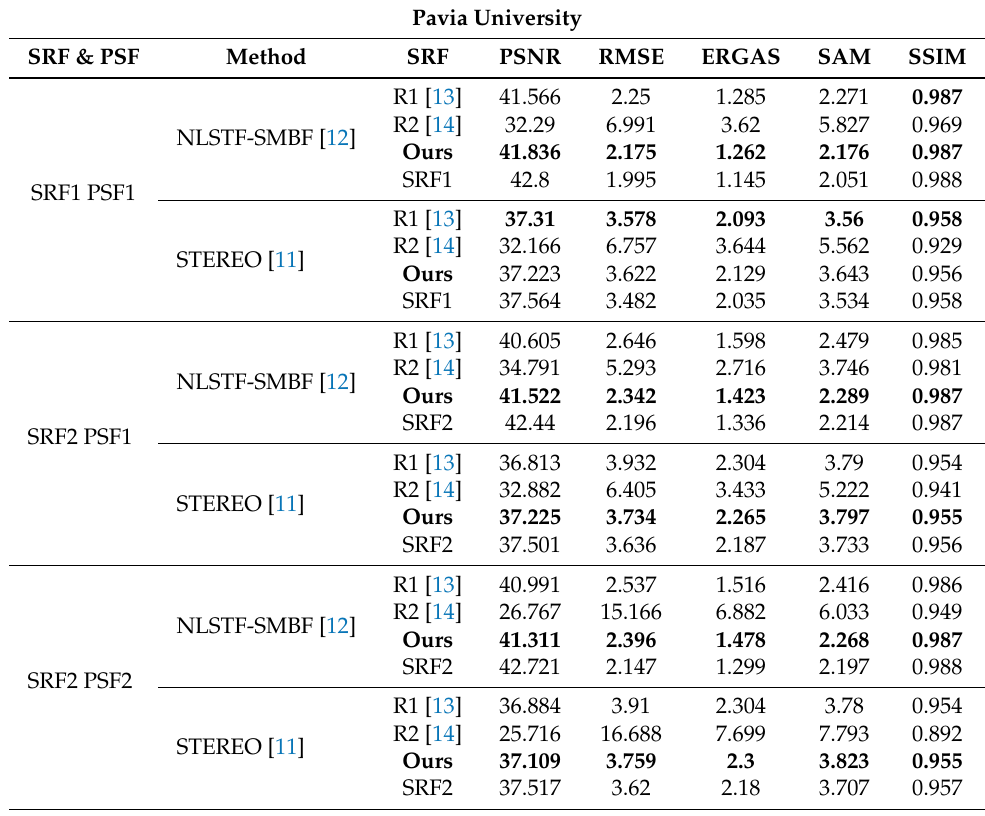
Table 2. Fusion results of objective metrics after two semi-blind methods using different SRFs on the Pavia University dataset.